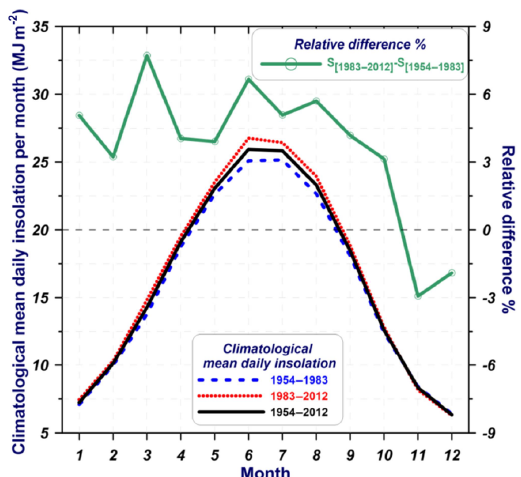
Figure 5. Intra-annual variability of monthly mean daily SSR over the sub-periods of 1954–1983 (blue line) and 1983–2012 (red line) and the entire period of 1954–2012 (black line). The green line (right axis) represents the monthly relative difference between the two 30-year sub-periods (recent minus older period).